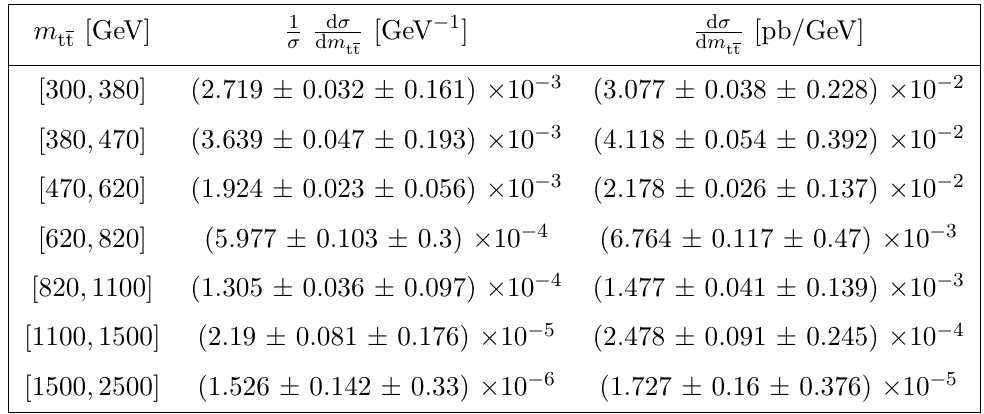
Table 26 . The measured di(cid:11)erential cross section and bin boundaries for each bin of the normalized and absolute measurements of the tt di(cid:11)erential cross section at particle level in the (cid:12)ducial phase space as a function of m are tabulated. tt